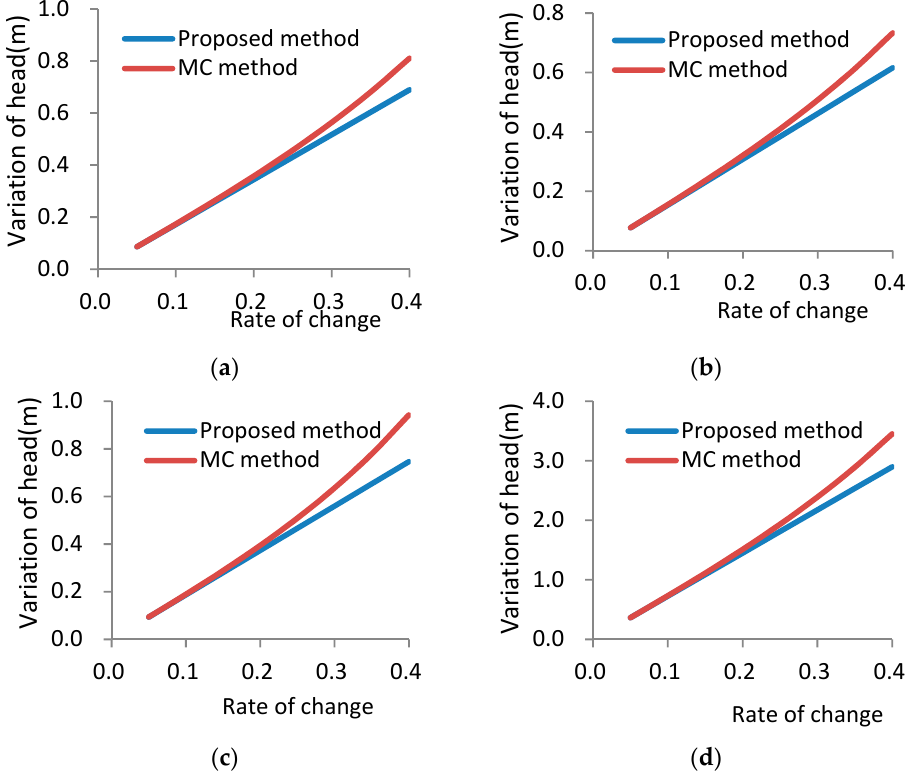
Figure 3. Comparison of the two methods in Scenario Two (( a ) observation well 2; ( b ) observation well 3; ( c ) observation well 4; ( d ) observation well 5).